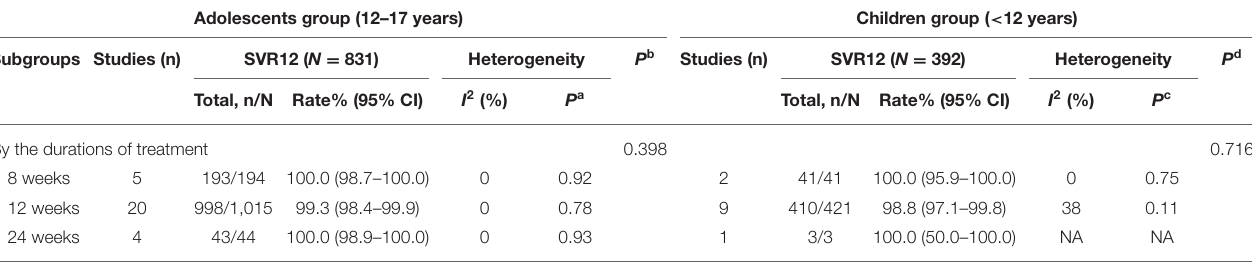
TABLE 2 | Rate of SVR12 after different durations of treatment in children and adolescents.